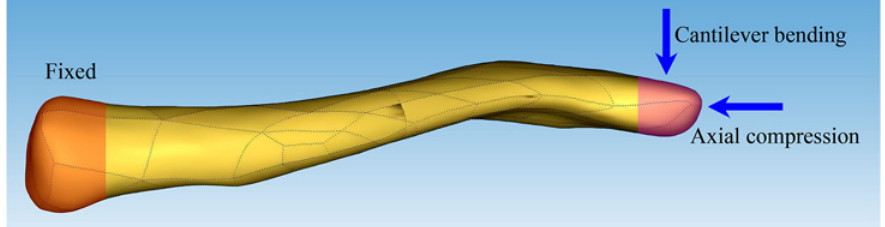
Fig 3. Diagram showing the loading directions of the 2 loading cases. The sternal side was held fixed in translation (orange). The external load was distributed over the distal side (purple), once for axial compression, and once for cantilever